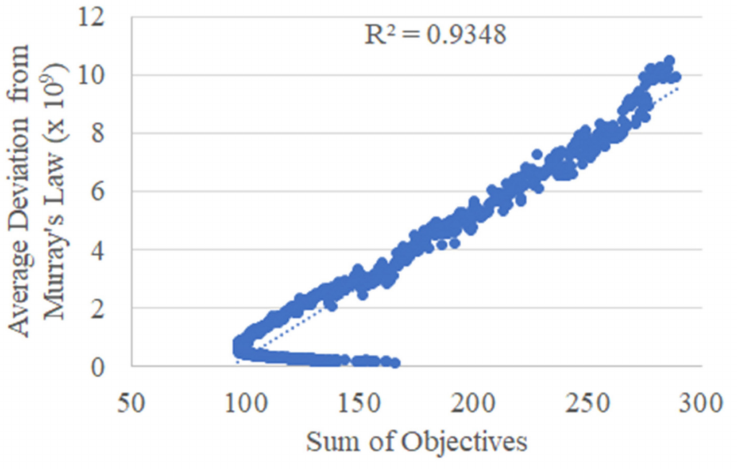
Figure 6. Plot of manufacturing and pressure cost (summed) for each NSGA-II solution vs. average deviation from Murray’s Law.